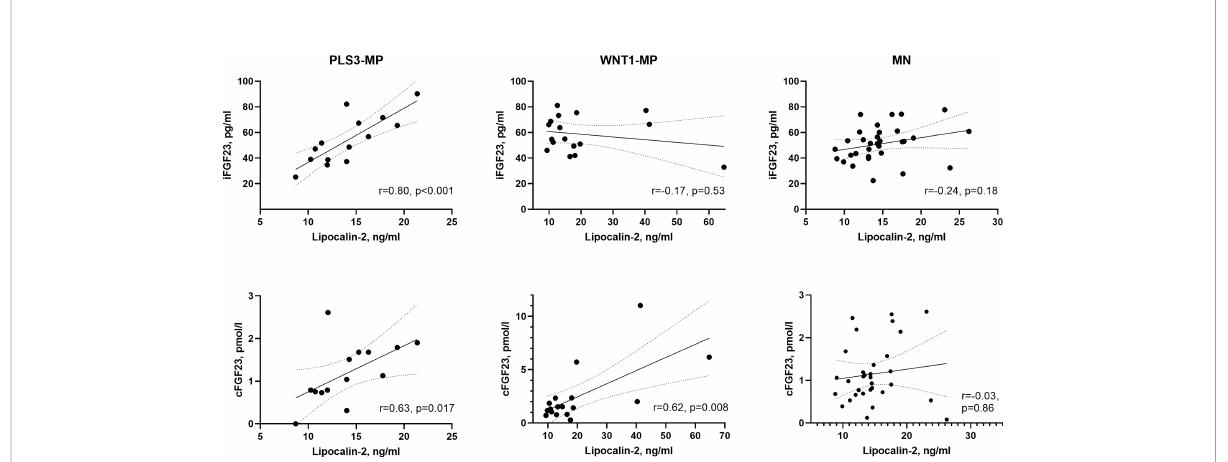
FIGURE 1 Scatter plots between lipocalin-2 and iFGF23, and lipocalin-2 and cFGF23 in PLS3, WNT1 and MN subjects separately. One outlier from MN subjects was excluded from fi gure. Pearson correlation coef fi cients (r) were calculated after log-transformation. Line represents simple linear regression with 95% con fi dence bands of the best- fi t line. PLS3-MP, PLS3 mutation-positive subjects; WNT1 mutation-positive subjects; MN, mutation negative subjects; iFGF23, intact fi broblast growth factor 23; cFGF23, C-terminal fi broblast growth factor 23.